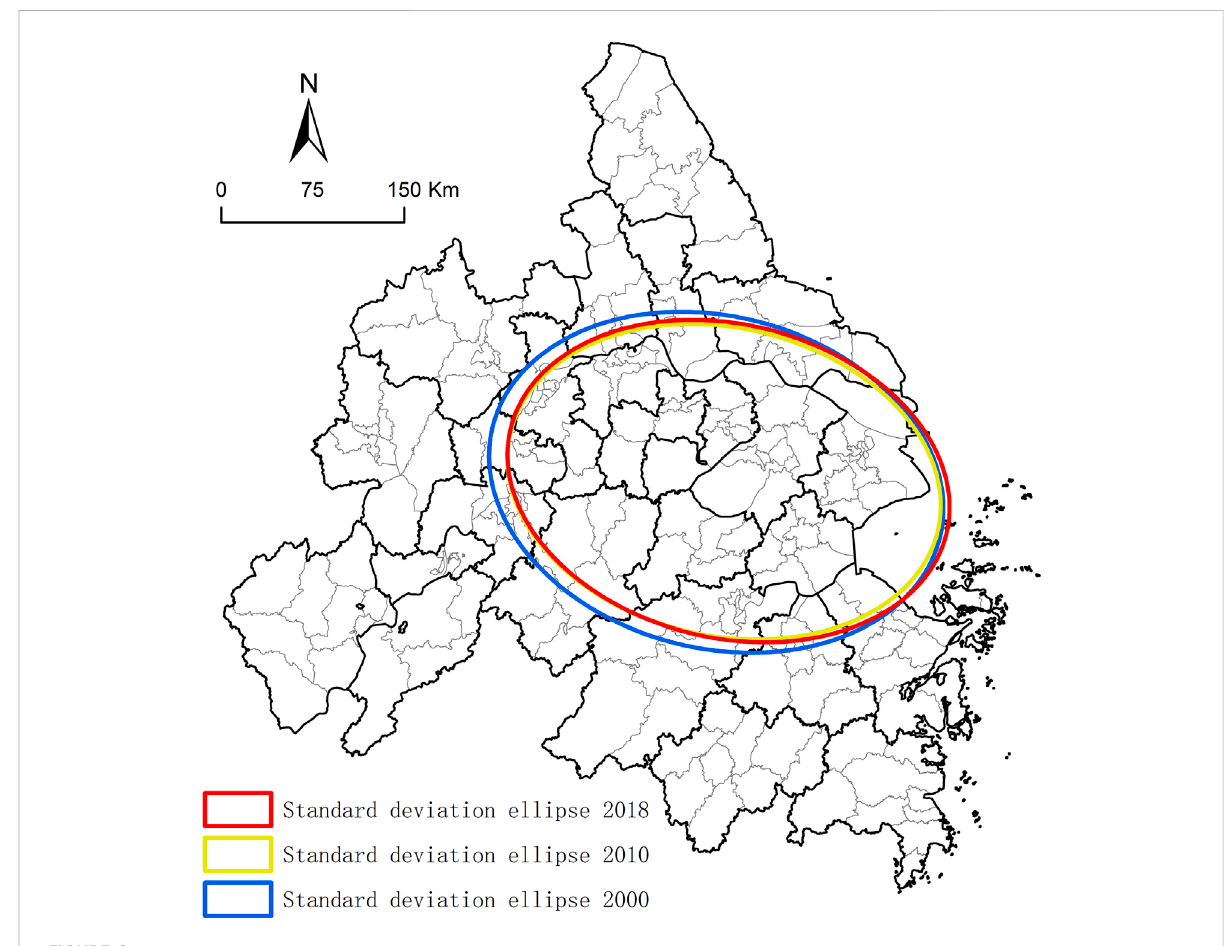
FIGURE 6 Transfer path of carbon emissions in the Yangtze River